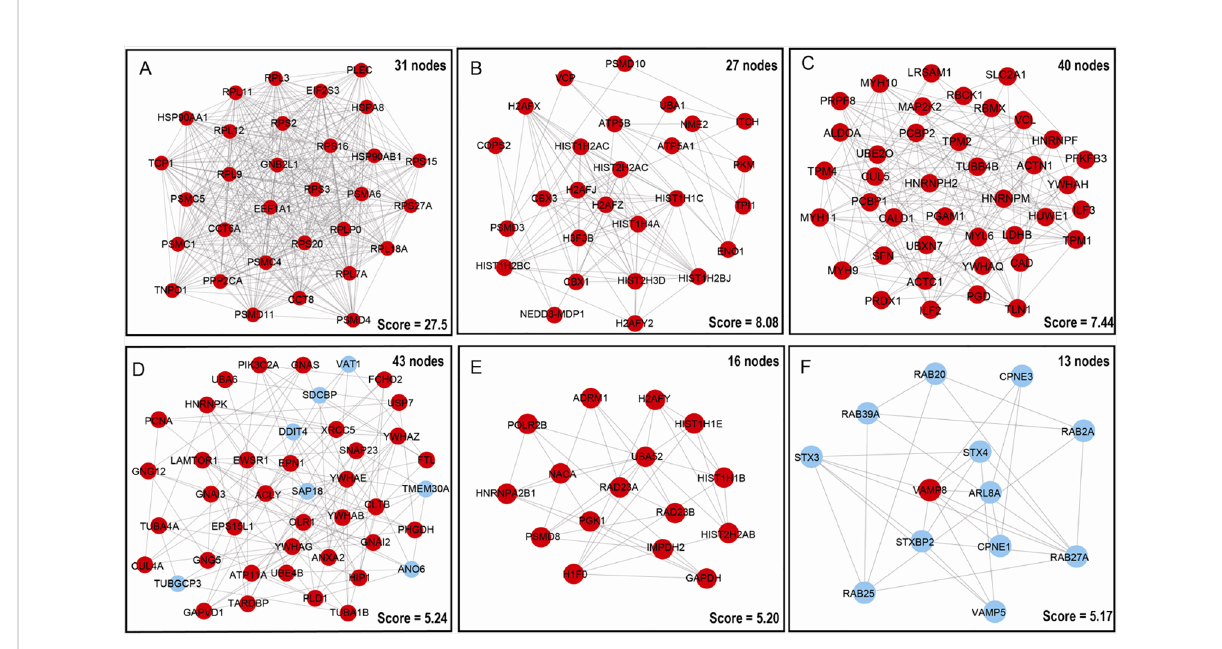
FIGURE 5 Molecular interaction modules and hub nodes based on PPI molecular networks of 627 UPs. (A – F) Six molecular interaction modules that meet screening criteria derived from the entire UPs PPI network. Red nodes represented the hub molecules. Blue node means it was not recognized as hub molecule due to low